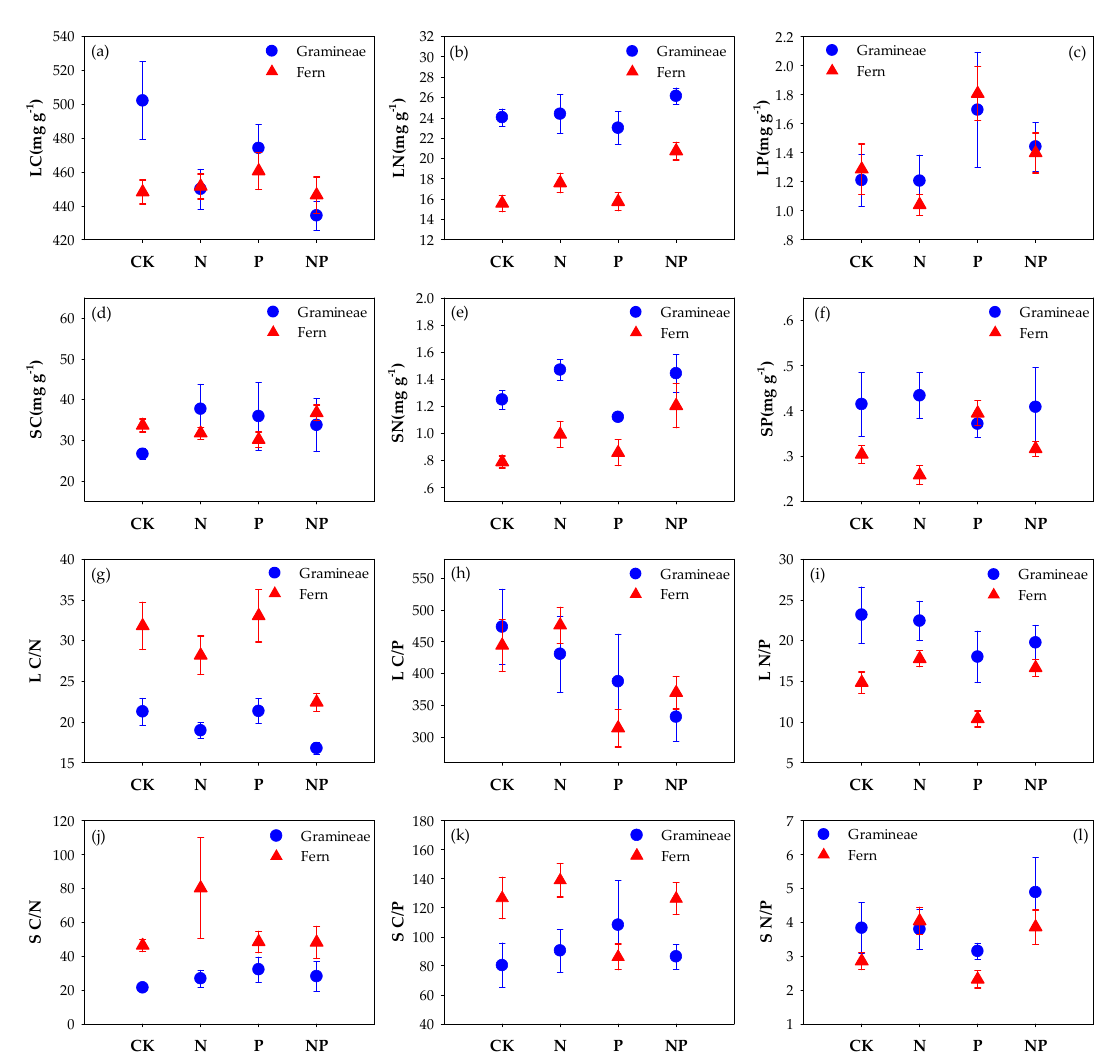
Figure 2. Litter and soil carbon, nitrogen, and phosphorus (C, N, P), C / N, C / P and N / P of four dominate species with two di ff erent functional types (Gramineae Lophatherum gracile and fern Woodwardia japonica , Dryopteris atrata and Dicranopteris dichotoma ) under four nutrient addition modes (CK, N, P and NP). Terms are the same as in Table 2.